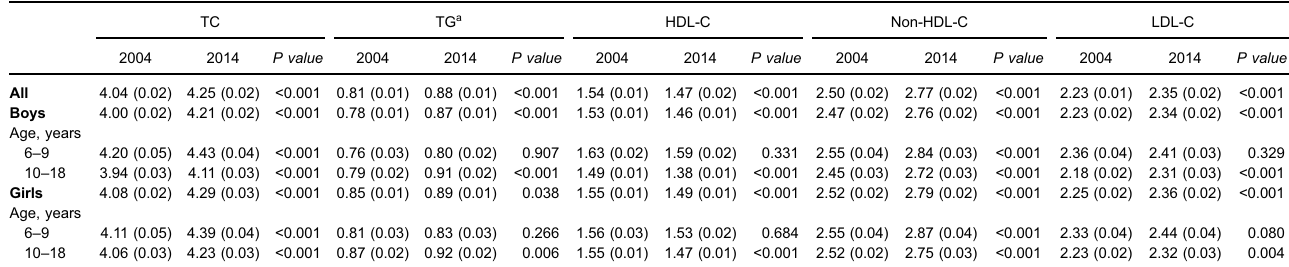
Table 2. Mean serum lipid concentrations over time by sex and age among children and adolescents in Beijing, 2004 – 2014 TC TG a HDL-C